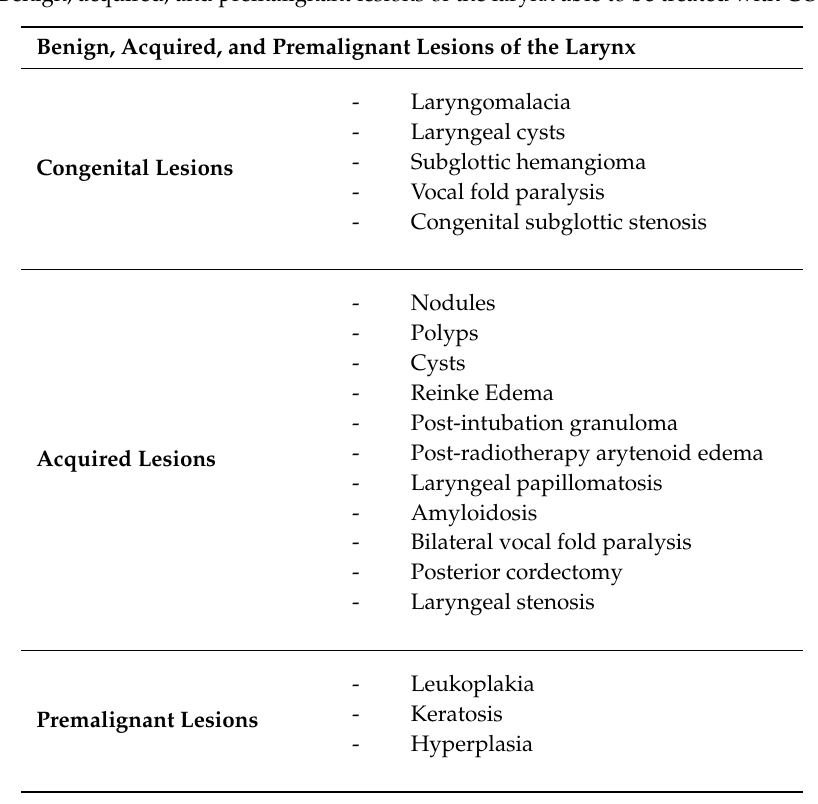
Table 2. Benign, acquired, and premalignant lesions of the larynx able to be treated with CO 2 TOLMS.